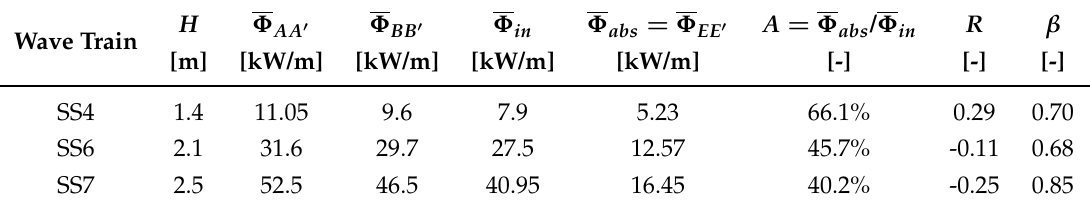
Table 5. Summary of the simulations.